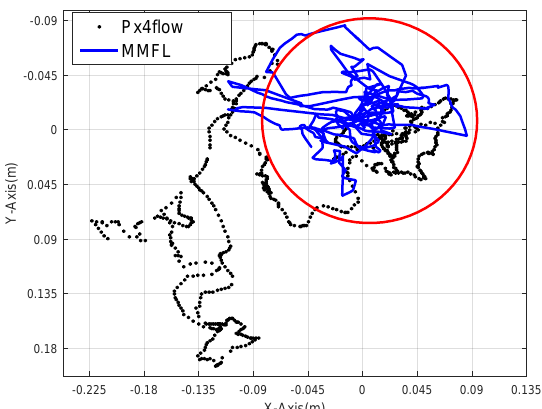
Figure 13. Hover Trajectory of the Proposed System and Px4Flow.